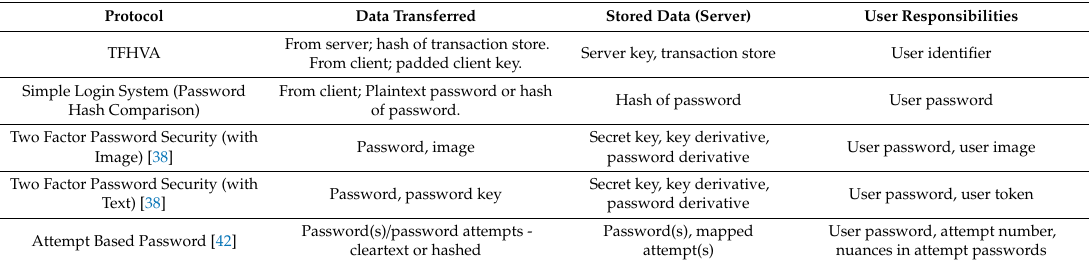
Table 3. Data stored and transferred within each protocol, as well as data user is responsible for.